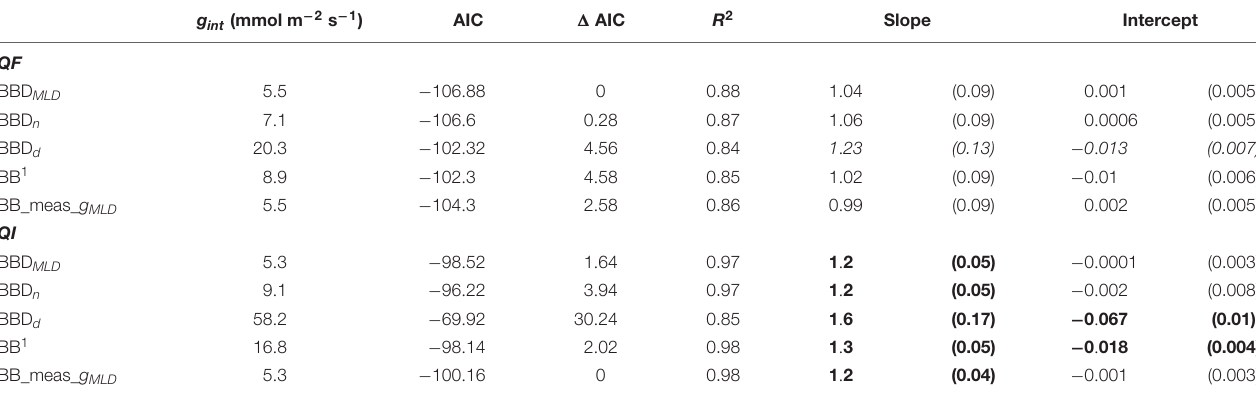
TABLE 2 | Model comparison. We compared for Q. faginea (QF) and Q. ilex (QI) different models based on the Akaike Information Criterion (AIC), the change in AIC relative to the lowest ( (cid:49) AIC) and the R 2 , slope and intercept of the observed vs predicted relationship. For the slope and intercept we show the mean value (and